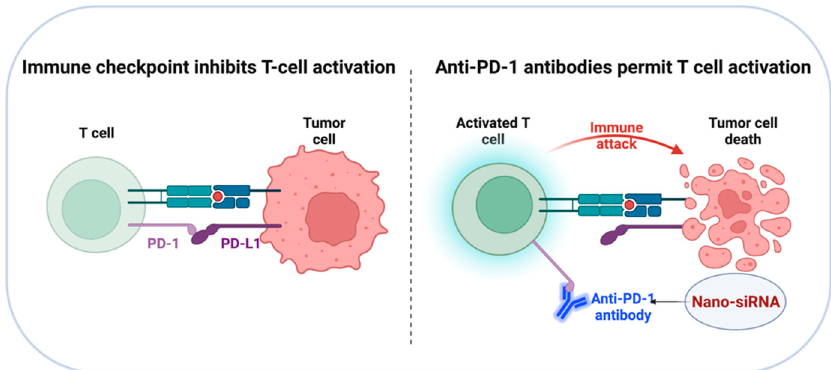
Figure 6. Diagrammatic illustration of immune checkpoint blockade therapies. Inhibiting the ligand–receptor interaction of PD-1/PD-L1 to prevent the activation of PD-1/PD-L1 signaling pathway, leading to T cell activation and reduction of tumor cell proliferation.